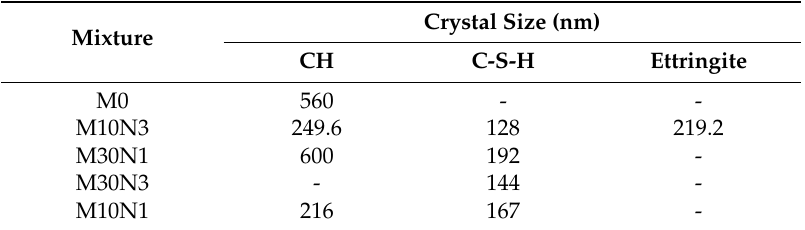
Table 6. Average size (nm) of crystals present in different mixtures.